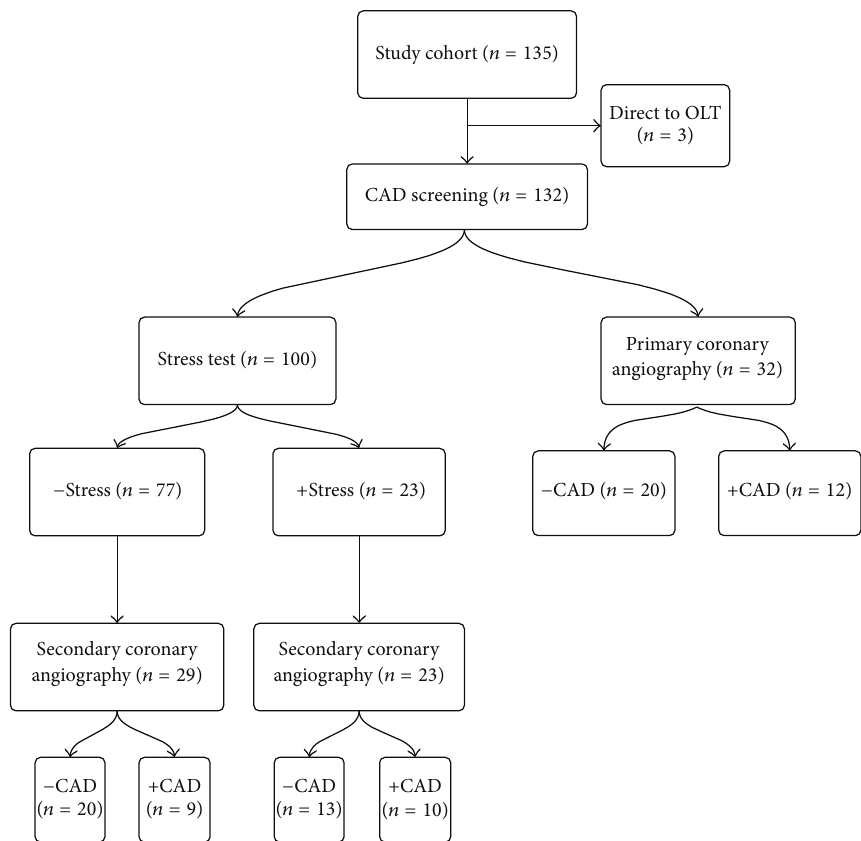
Figure 1: Positive stress test is defined as signs of ischemia on ECG during exercise, signs of ischemia on nuclear perfusion stress, and/or signs of infarction on perfusion study. Positive coronary artery disease was defined as at least a single vessel with ≥ 50% stenosis. ECG: